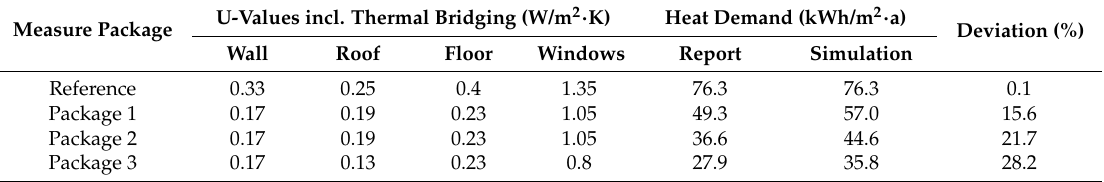
Table 5. Comparison between report and simulation results for heating demand, different